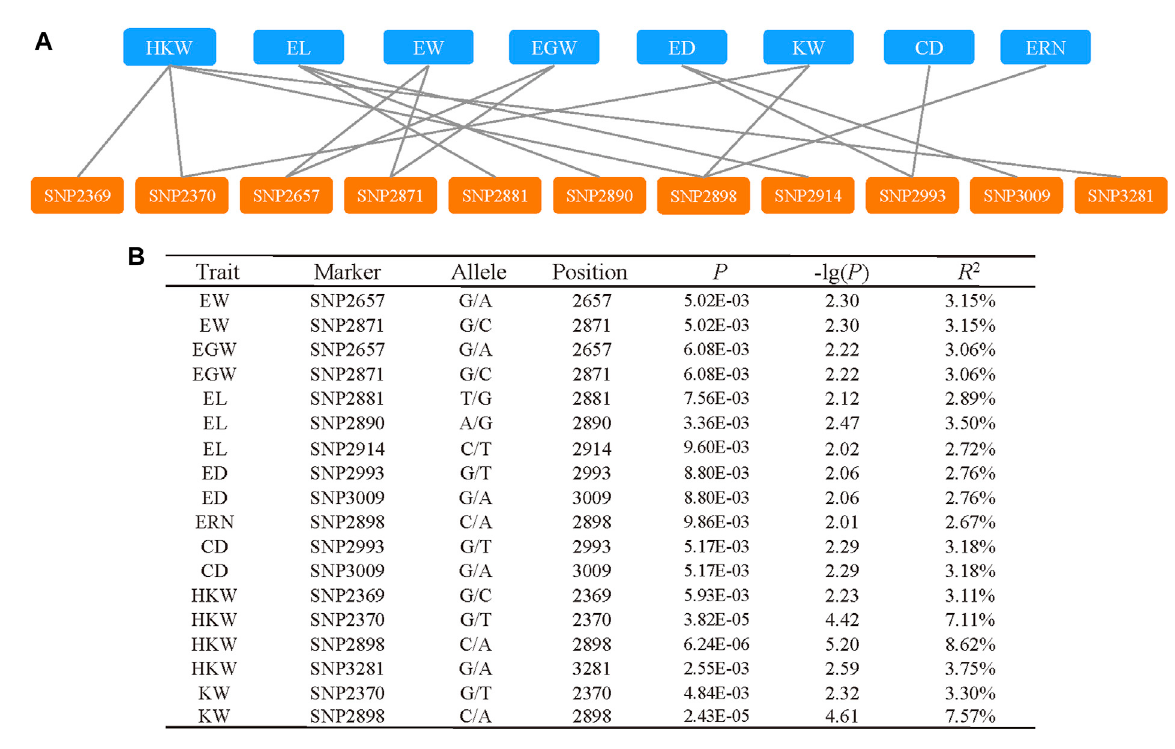
FIGURE 5 Signi fi cant markers associated with phenotypic traits. (A) The network between pleiotropic site and associated traits. (B) The information of signi fi cant markers which associated with